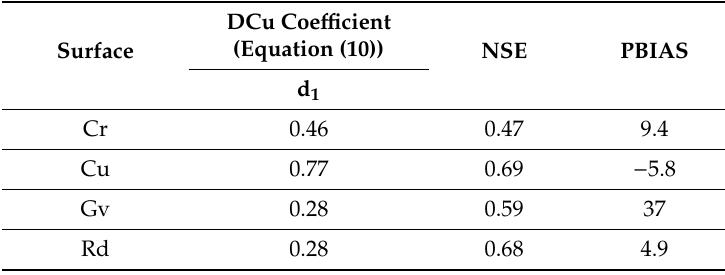
Table A7. Optimized MEDUSA2.0 model coe ffi cient values and goodness of fit statistics for